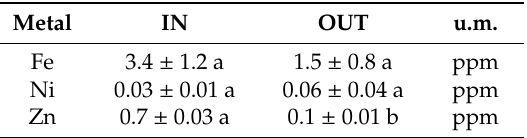
Table 4. Physical and chemical characteristics of PL in inflow and outflow. Di ff erent letters indicated that the di ff erences were significant ( p -value < 0.05). Metal IN